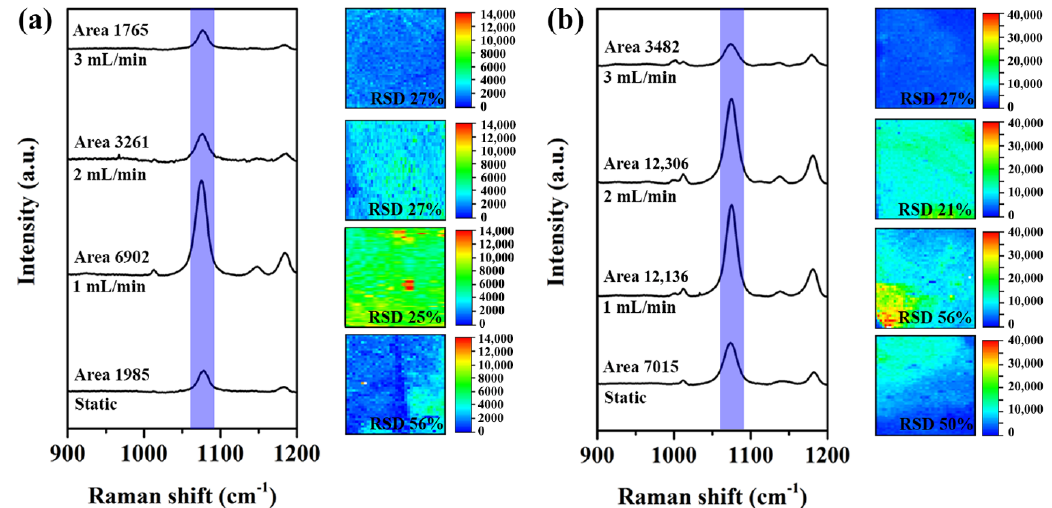
Figure 8. SERS efficiency evaluation and false colour intensity maps for the samples synthetized using ( a ) 10 mM AgNO 3 at 20 °C with different flow rates, and ( b ) 100 mM AgNO 3 at 20 °C with different flow rates. The spectra and maps corresponding to the samples prepared in static conditions are shown at the bottom of each SERS graph. The SERS spectra in this figure are the average of all the spectra collected by the mapping.